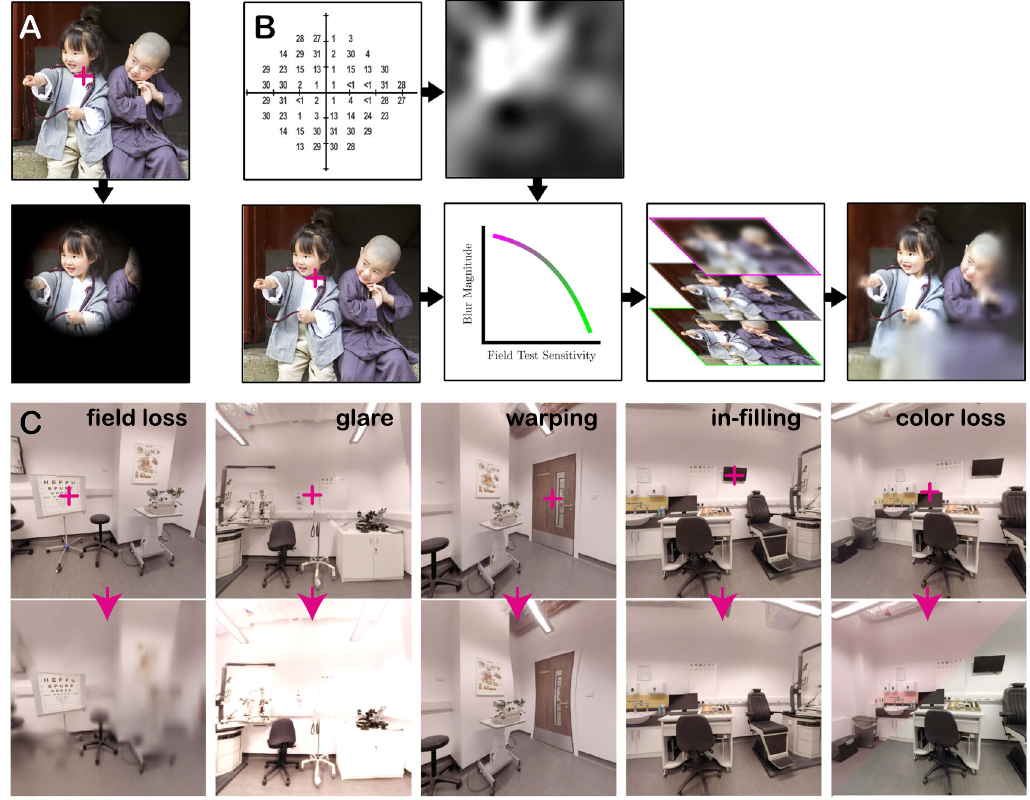
Fig. 1 Simulations of sight loss. a Example of a conventional depiction of peripheral vision loss (e.g., glaucoma) using a crude method of occlusion. Such simulations are typically regarded as unrealistic by patients 2 ; b Peripheral vision loss as simulated in OpenVisSim. Clinical visual fi eld data from static automated perimetry is used to construct a gaze-contingent fi eld map, which speci fi es the amount of blur to apply to each pixel. See Methods for details; c Examples of other potential image manipulations supported by OpenVisSim (not evaluated in the present paper). Additional visual disturbances, such as nystagmus, non-stationary warping, dynamic noise, and binocular misalignment (strabismus), are also supported, but cannot be easily illustrated using individual static images. For a video demonstrating many of these effects, see Supplementary Video